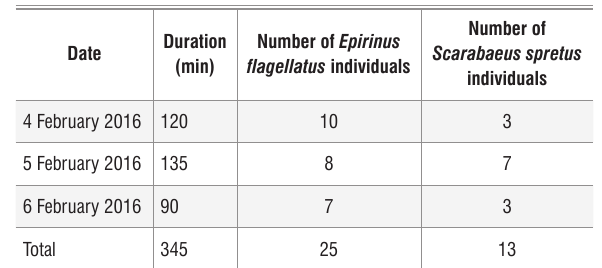
Observations of dung beetles at Ceratocaryum argenteum seed stations at Potberg